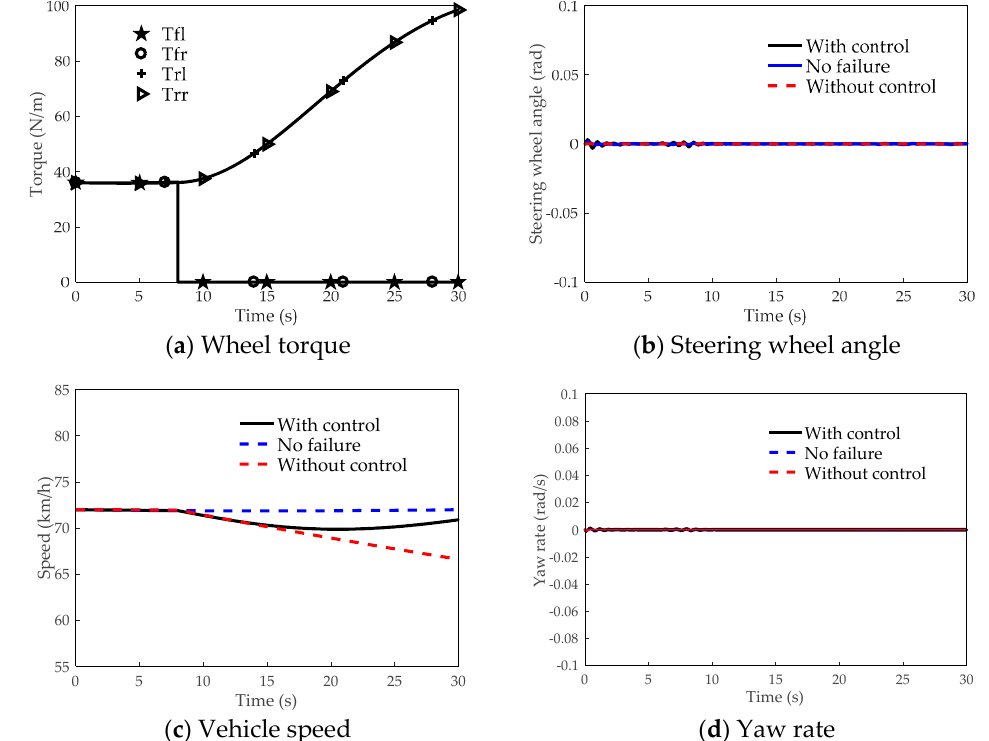
Figure 4. Simulation comparison with/without control under F2 condition. Table 7. Statistical control effect under F2 condition.